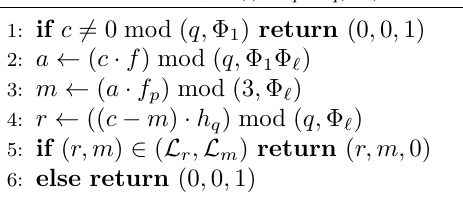
Algorithm 3 Decrypt (( f, f p , h q ) , c ) Algorithm 6 Decapsulate (( f, f p , h q , s ) , c